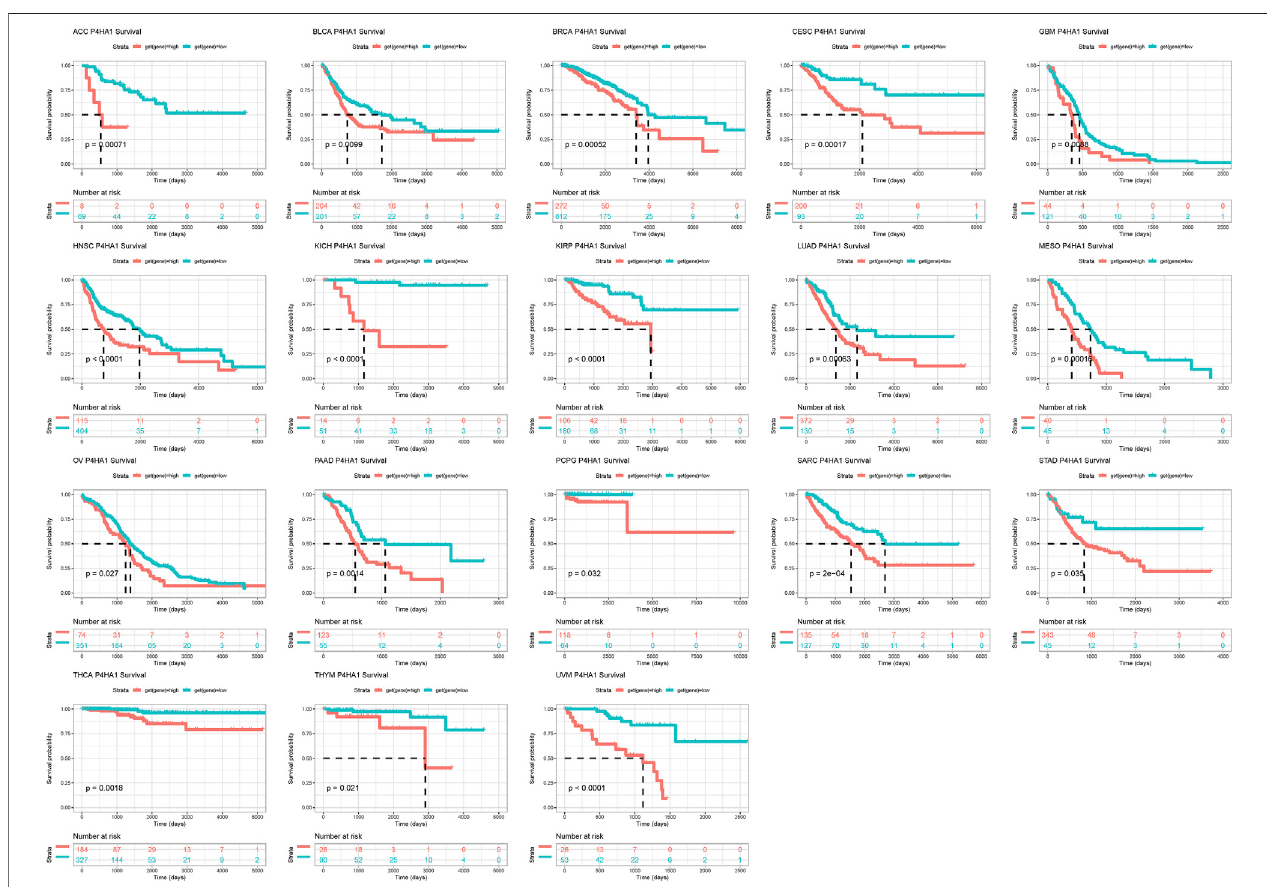
FIGURE 4 | Prognostic value of P4HA1. Kaplan-Meier OS analysis of P4HA1 in TCGA pan-cancer in indicated tumor types.